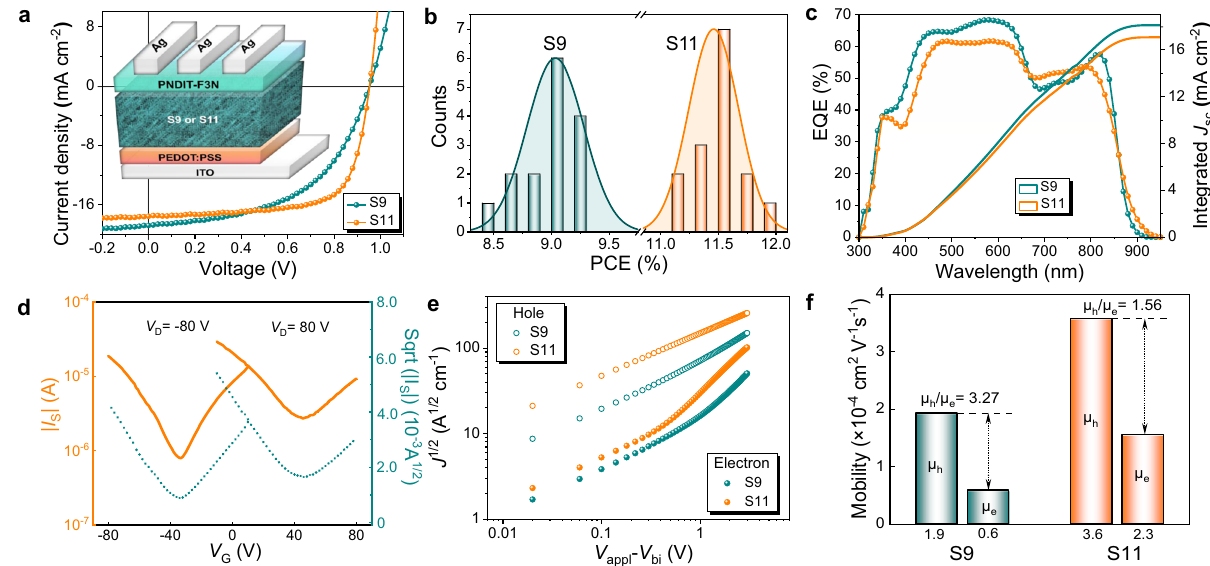
Fig. 2 | Photovoltaic properties of OSCs. a J – V characteristics for OSCs and the corresponding device structure used in this work. b Histograms of the PCE counts for 15 individual devices. c EQE spectra and integrated J sc for devices based on S9 and S11. d Transfer characteristics of the S11-based top-gate/bottom-contact